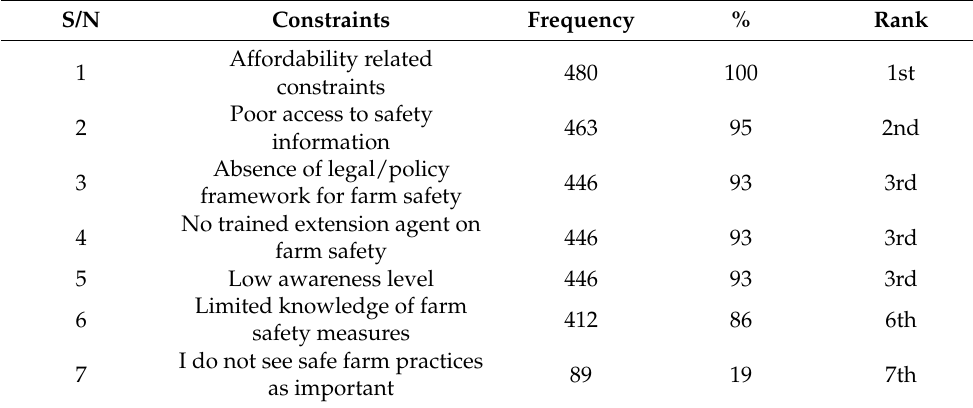
Table 5. Constraints to farmers’ adoption of safe farm practices N =